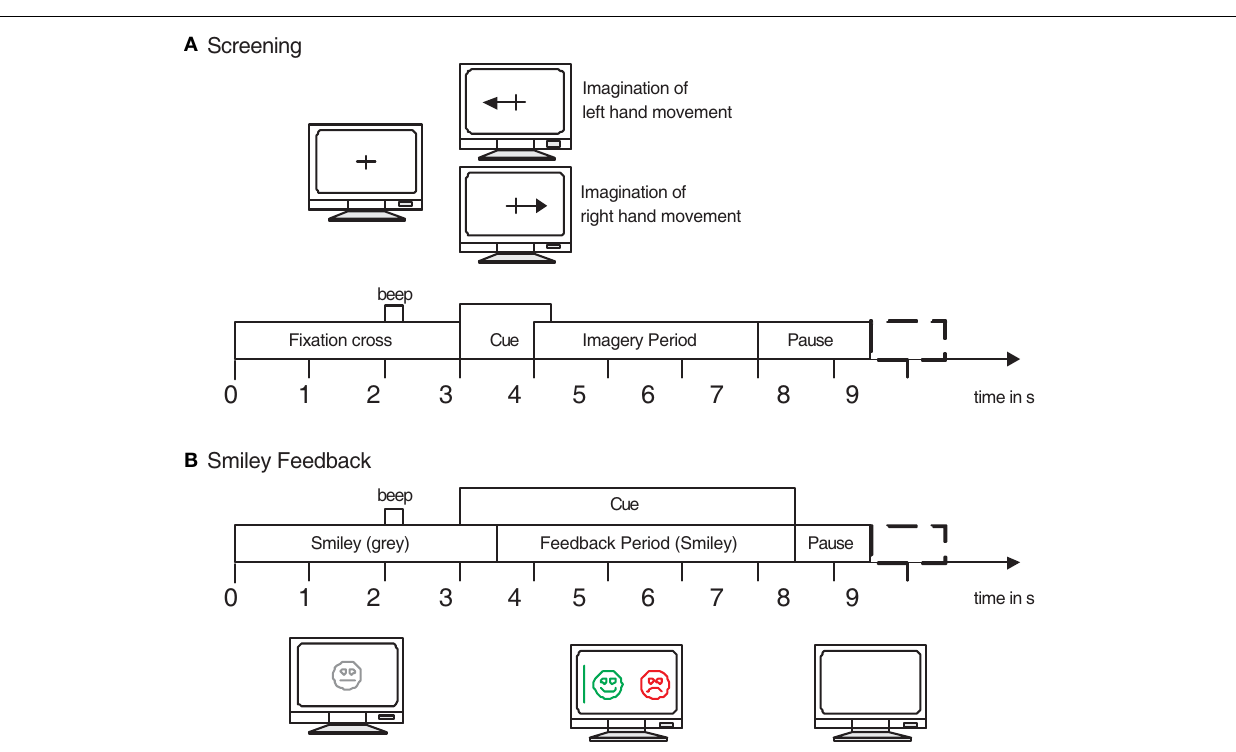
FIGURE 20 | (Data Set 2b). Timing scheme of the paradigm. (A) The first two sessions (01T, 02T) contain training data without feedback, and (B) the last three sessions (03T, 04E, 05E) with smiley